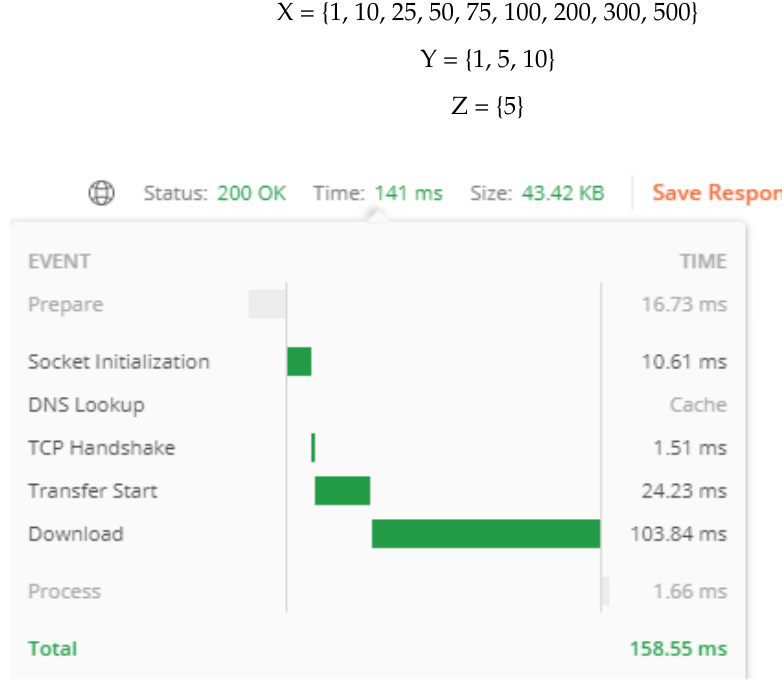
Figure 8. Break-up of a response time in our proposed solution for a single authorized HTTP request. Table 11. Scalability testing results with Y = 1, Z = 5, and variable loads (X).